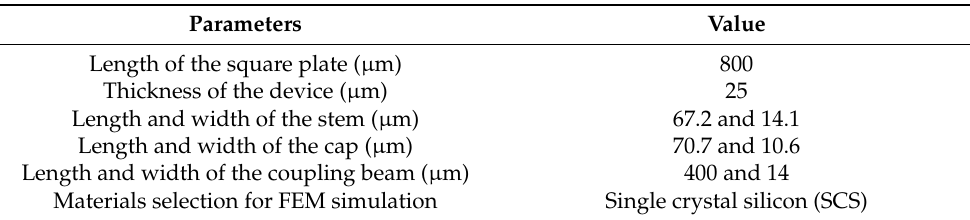
Table 2. Dimensions and materials of a 2-DoF coupled BAW square plate resonator system modeled in COMSOL (Adapted with permission from Ref. [26]).